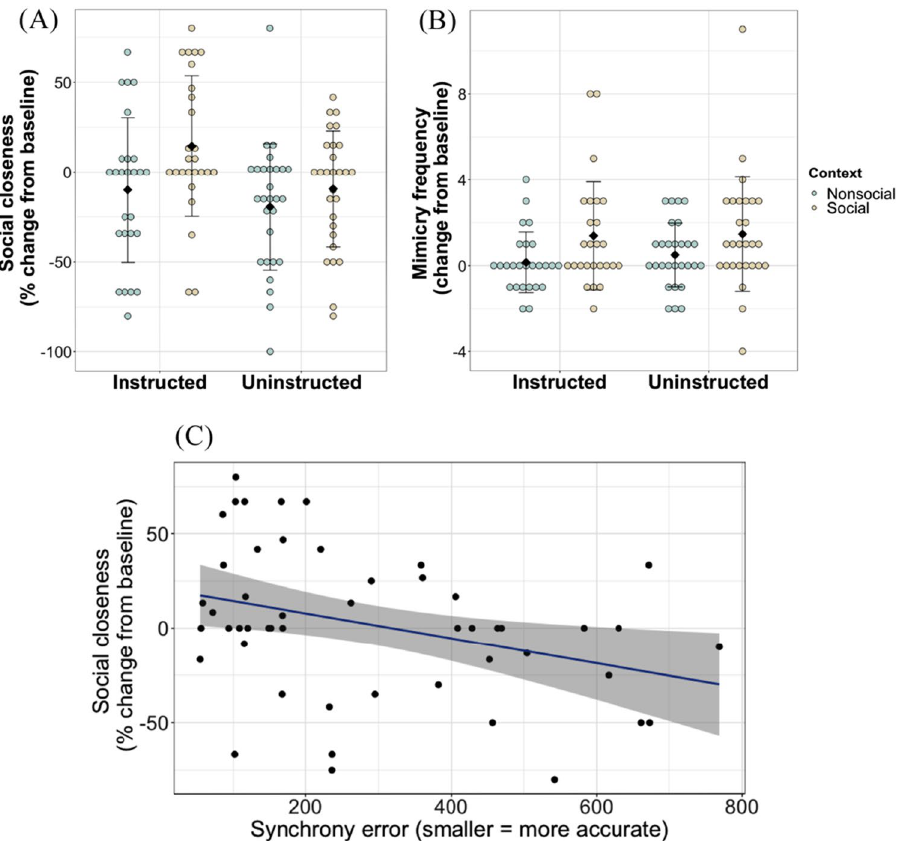
Figure 4. Social bonding by context, instruction and synchronisation accuracy in children. In ( A ) and ( B ), coloured dots indicate individual data points, black diamonds indicate group mean and whiskers indicate standard error of the mean. ( A ) Change in social closeness (test-baseline) per context and instruction condition, with positive scores indicating an increase and negative scores indicating a decrease in closeness as compared to baseline. ( B ) Change in mimicry frequency (test-baseline) per social context and instruction condition, with positive scores indicating an increase and negative scores indicating a decrease in mimicry as compared to baseline. ( C ) Relationship between synchrony error and change in social closeness within the social context. Shading indicates 95 confidence